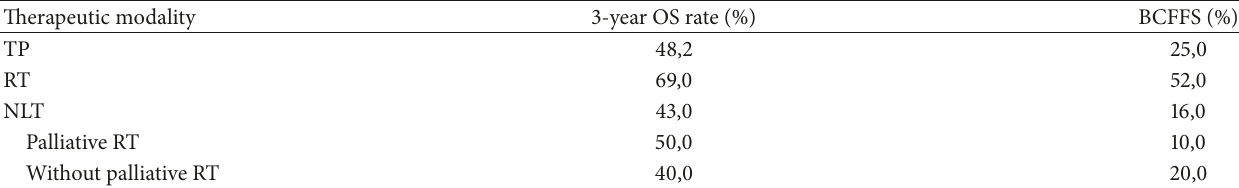
Table 9: Overall survival and overall survival rates by therapeutic modality, adapted from Rusthoven et al. (2016) [17]. OS (months) 3-year OS rate (%) 5-year OS rate (%) 8-year OS rate (%) RT + ADT 53 62,0 49,0 33,0 ADT 29 43,0 25,0 13,0